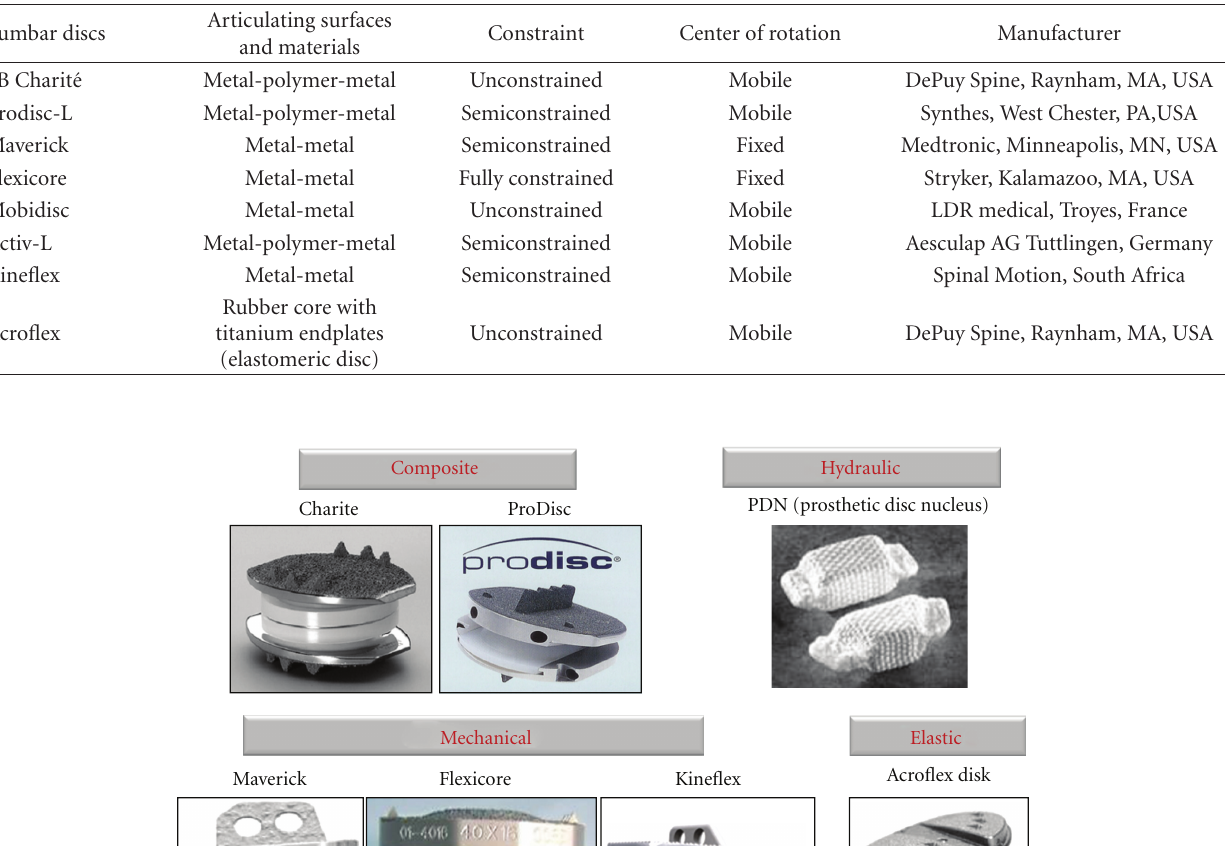
Table 2: Table lists di ff erent lumbar artificial discs and respective types of materials and features [60–63] .